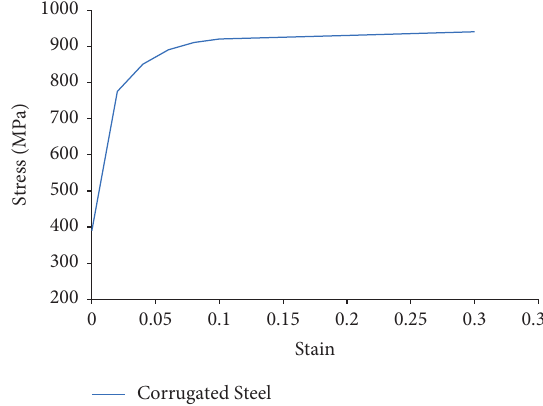
Figure 3: Stress-strain curve (ID � 1) of corrugated steel.